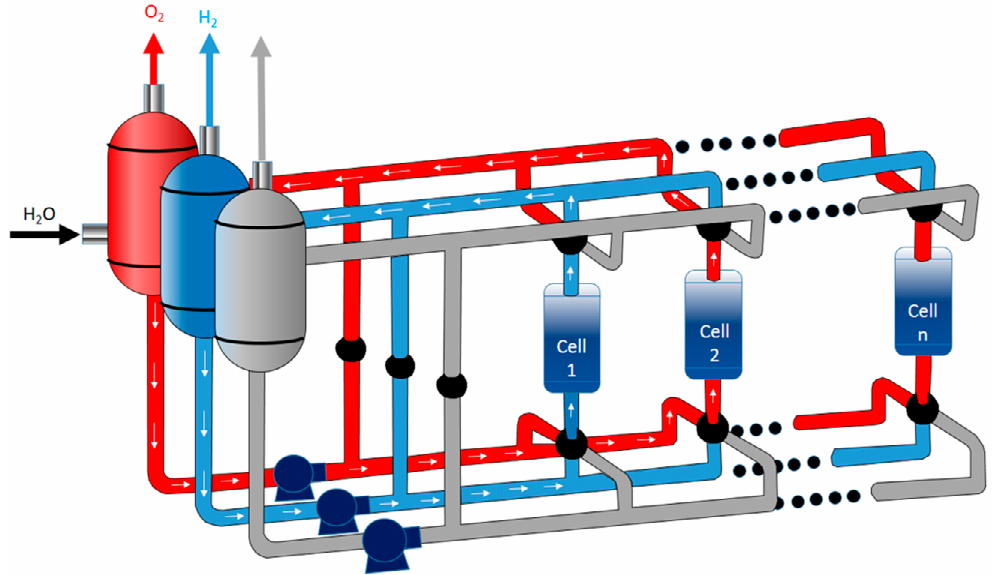
Figure 5. E-TAC multi-cell design.